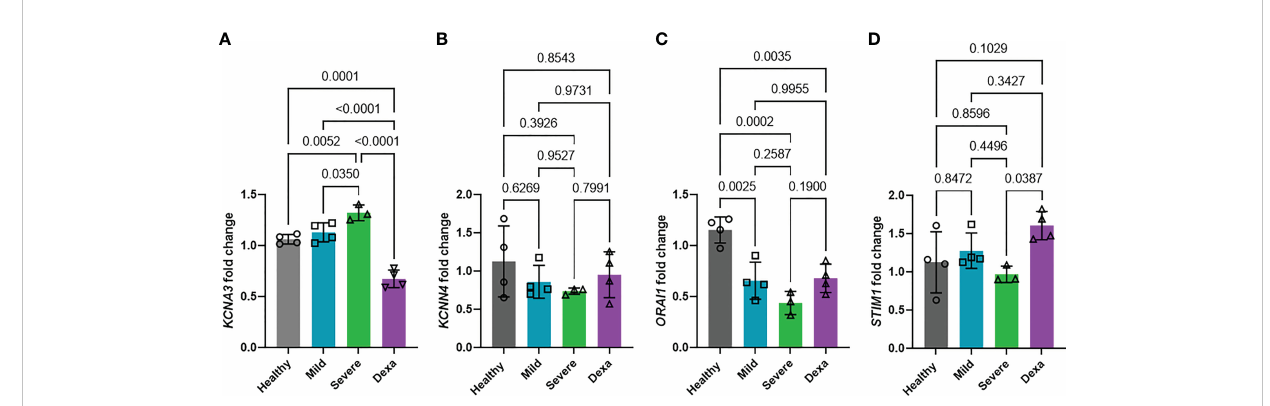
FIGURE 4 Changes in ion channel expression with disease progression and dexamethasone treatment. Fold change in mRNA abundance of Kv1.3 ( KCNA3 , A ), KCa3.1 ( KCNN4 , B ), Orai ( ORAI1 , C ) and Stim1 ( STIM1 , D ) in PBMCs from healthy donors (n=4), and patients with mild COVID-19 (n=4), severe COVID-19 (Severe, n=3), and severe COVID-19 + dexamethasone (Dexa, n=4) was determined by RT-qPCR. Data are normalized to healthy donor PBMCs. Each sample was run in triplicate. 18S rRNA was used as the housekeeping gene. Bars represent means ± SD, and each symbol represents an individual patient. Data were analyzed by one-way analysis of variance (ANOVA) (P < 0.001 in A , P = 0.4270 in B , P=0.0003 in C, and P=0.0414 in D ), and post hoc testing was performed by the Holm-Sidak